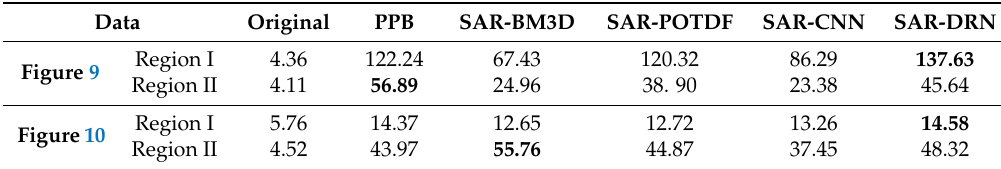
Table 6. EPD-ROA indexes for the real despeckling results.